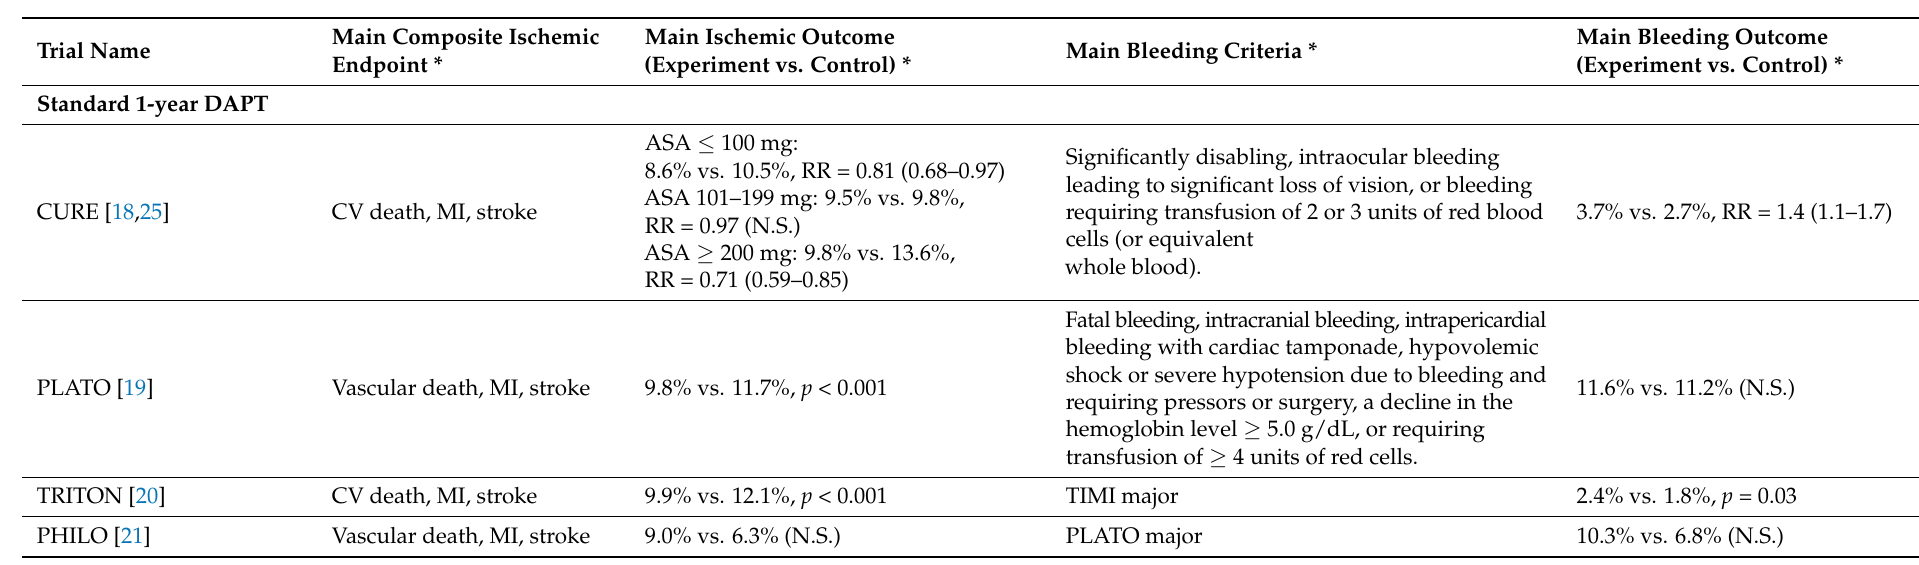
Table 3. Outcomes of major international and Asian randomized controlled trials investigating the efficacy and safety of popular antiplatelet therapy